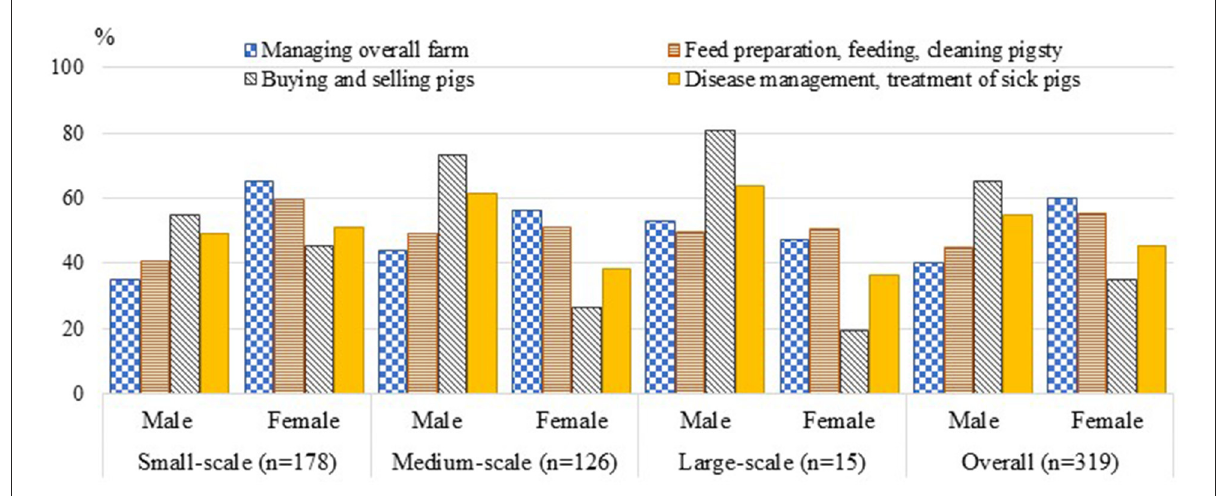
FIGURE1 Gendered participation in deciding and performing tasks in pig farming (% time allocated). Small-, medium-, and large-scale farms were defined as having respectively ≤ 10, 11–30, and > 30 pigs in the latest